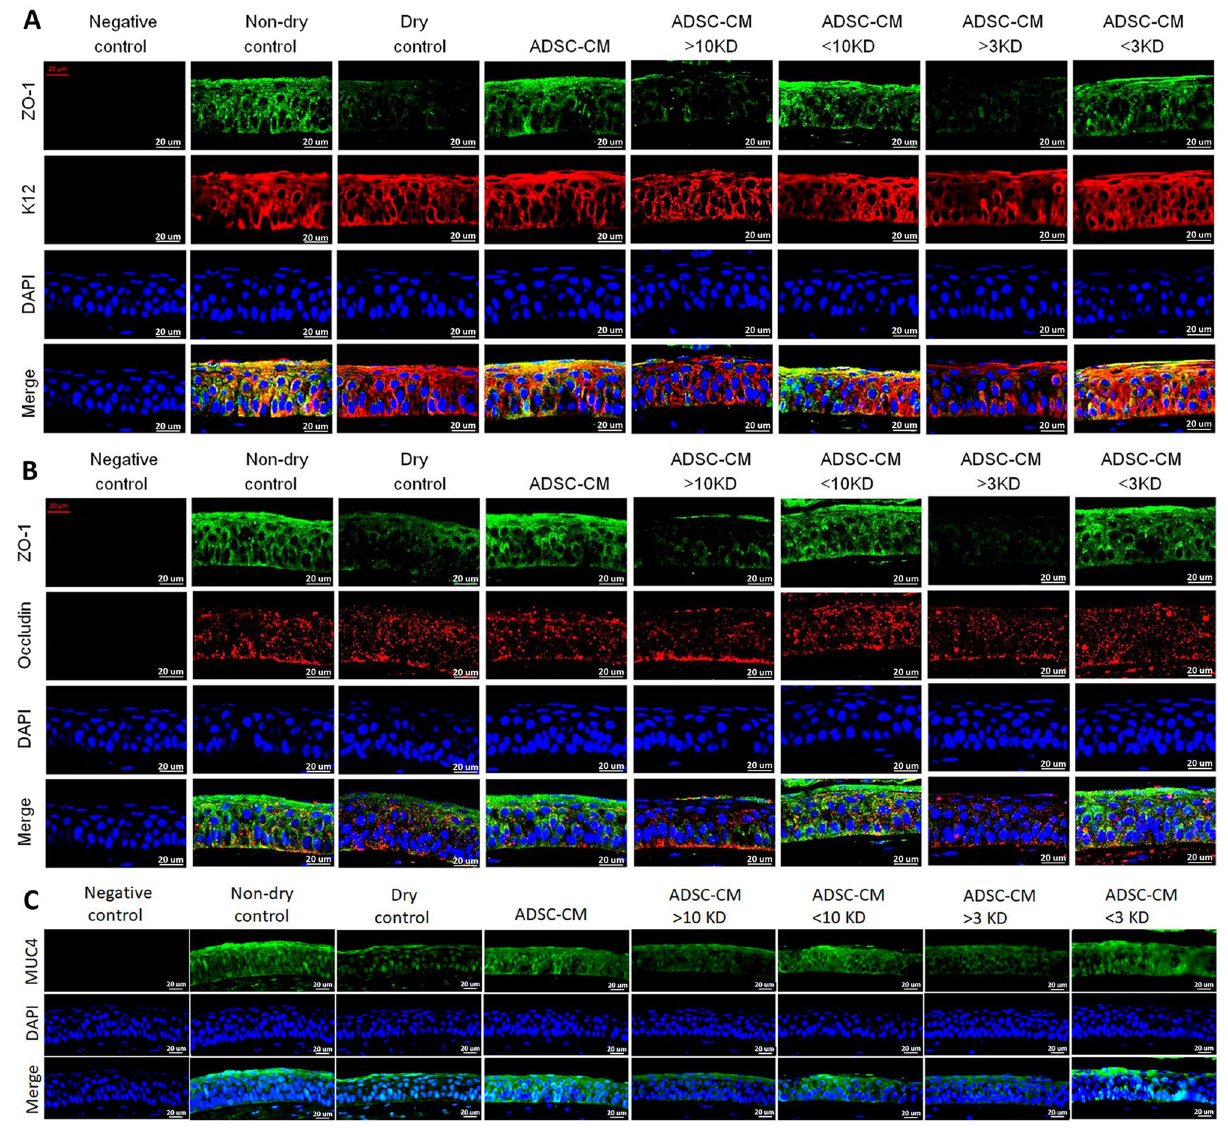
Figure 4. Confocal examination of tight junction and MUC4 expression of the corneal epithelium in the CEC mice. Mice treated with fractions of ADSC-CM with molecular size < 10 kD or < 3kD showed better expression of (A) ZO-1 and K12, (B) ZO-1 and occludin, and (C) MUC4 than those treated with fractions > 10 kD or > 3 kD. (N = Human corneal epithelial cells (HCECs) culture. Normal primary HCECs from American Type Cul- ture Collection (ATCC ® , Manassas, VA, USA) were maintained according to the instructions. The HCECs were grown in a corneal epithelial cell basal medium supplemented with corneal epithelial cell growth kit components (CEM, ATCC ® ). The cells were cultured at 37 °C in a moist atmosphere with 5% carbon dioxide. The culture medium was changed every 2 or 3 days. In this study, only sub-confluent HCECs at passage three were used. Desiccating stress. A modified in vitro desiccation stress on HCECs was used in our study 55,57,96 . Briefly, 2 × 10 4 HCECs were seeded in 96-well dishes and cultivated for 24 h to attach to the dishes (about 80% conflu- ence). The medium was aspirated, and the dishes were left dry for 10 min at 37 °C. After desiccation, the test- ing culture mediums were replenished to the respective culture dishes. The HCECs that did not undergo the desiccation stress were deemed as control. After incubation for four hours, the cells were counted using the Cell Counting Kit-8 (CCK-8 assay). Hyperosmolarity stress. 1.5 × 10 4 HCECs were seeded in 96 well-dishes and cultivated overnight to attach to the dishes (approximately 60% confluence) and were then treated for 24 h with fresh medium (311 mOsm/ kg, normal control) or the medium containing another 90 mM NaCl (490 mOsm/kg, hypertonic groups). After